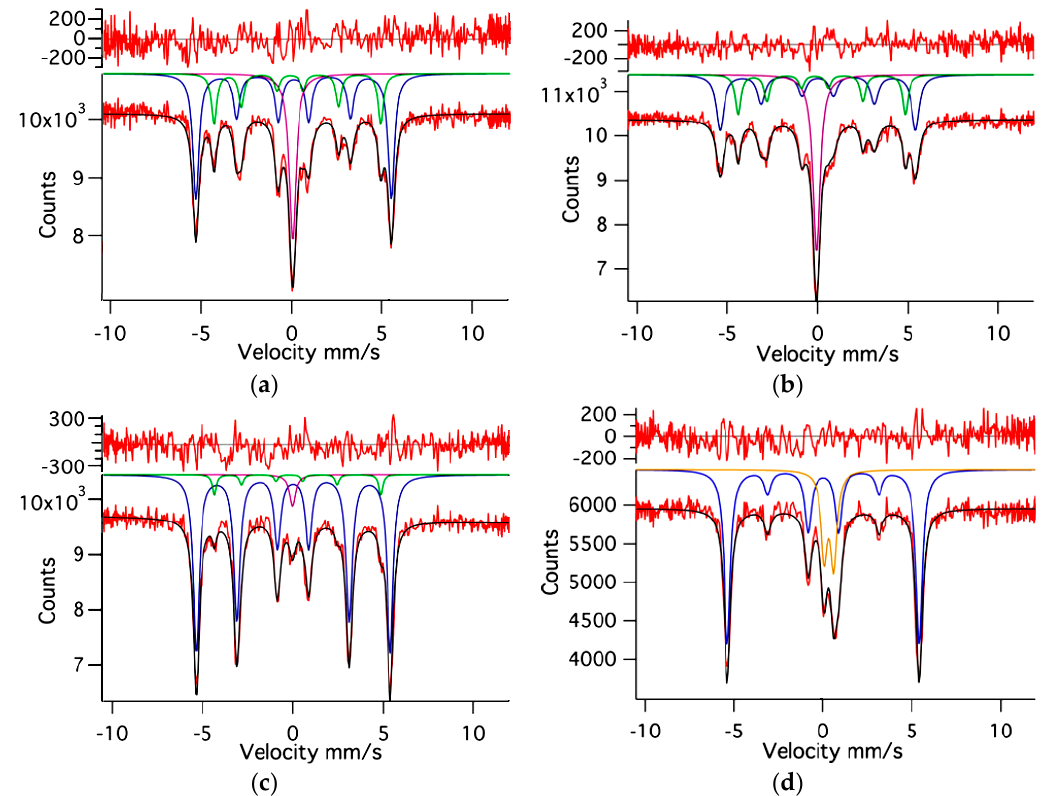
Figure 18. Selected room temperature synchrotron Mössbauer spectra measured for the Esquel PMG thin section: ( a ) the coarse cloudy zone, closer to the large kamacite lamella, ( b ) the fine cloudy zone, closer to plessite and ( c ) deep into plessite, and ( d ) the area containing schreibersite. Indicated components are the results of the fits. The differential spectra are shown on the top. Adapted from [43].